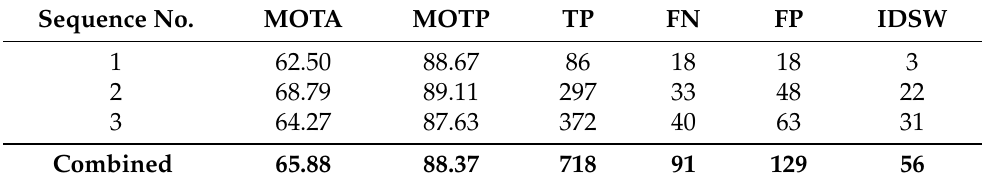
Table 6. Scenario 3—category 1 Quantitative results of the tracker’s performance to track objects of category 1 (large vessel) in scenario 3. Scenario 3 consists of three sequences involving both moving and static objects, occlusions of the camera’s viewpoint are applied.